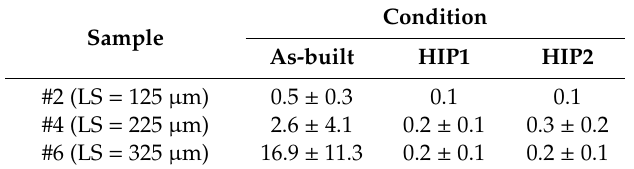
Table 4. Defect content (vol.%) in various samples in as-built and HIP’ed conditions.